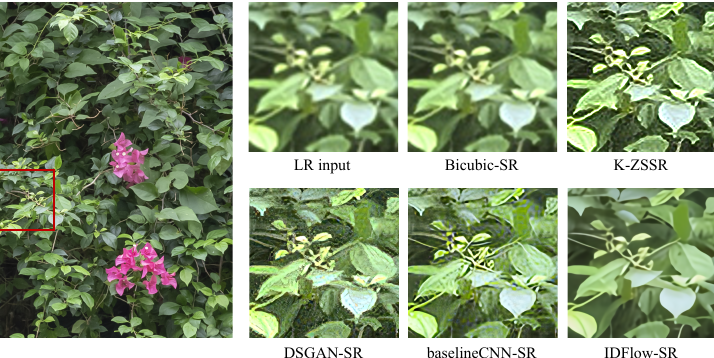
Figure 5. Visual comparisons of SR models on image “Nikon007” with a scale factor of 4 × . Local regions of the results are cropped and zoomed for a better visual